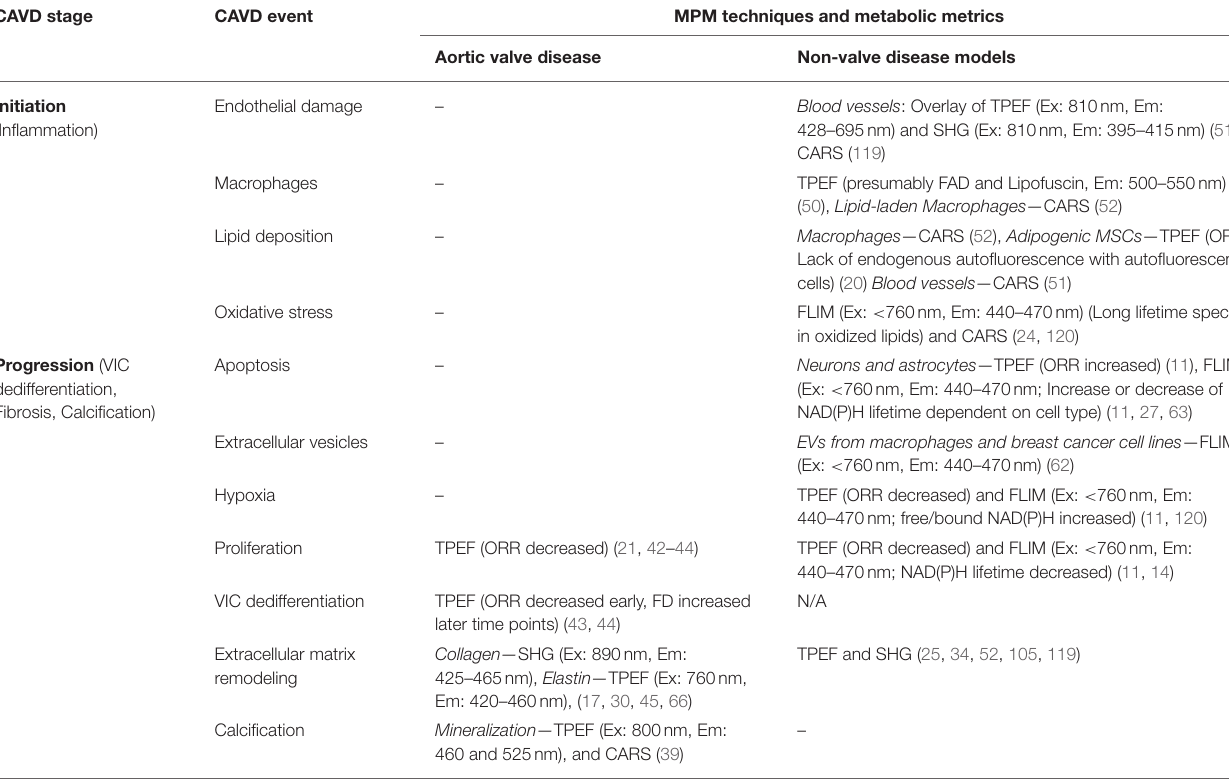
TABLE 1 | Summary of label-free MPM techniques and metrics associated with CAVD